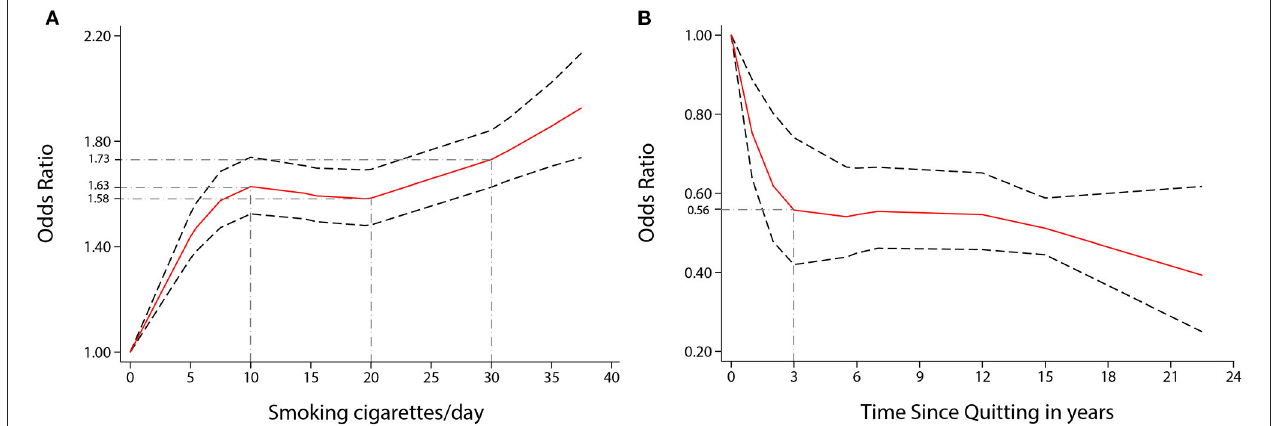
FIGURE 3 | Non-linear dose-response analyses of smoking/quitting and risk of stroke in meta-analysis. (A) Association between CPD and risk of stroke incidence restricted cubic splines with four knots (0, 5, 15.5, 35 CPD) and 0 CPD as a reference. P non-linearity = 0.0000. (B) Association between the length of time since quitting and the risk of stroke incidence restricted cubic splines with four knots (0, 1, 6, 22.5 years) and quitting 0 years as a reference. P non-linearity = 0.0022. The solid line represents the estimated OR, and the dashed lines represent the 95%